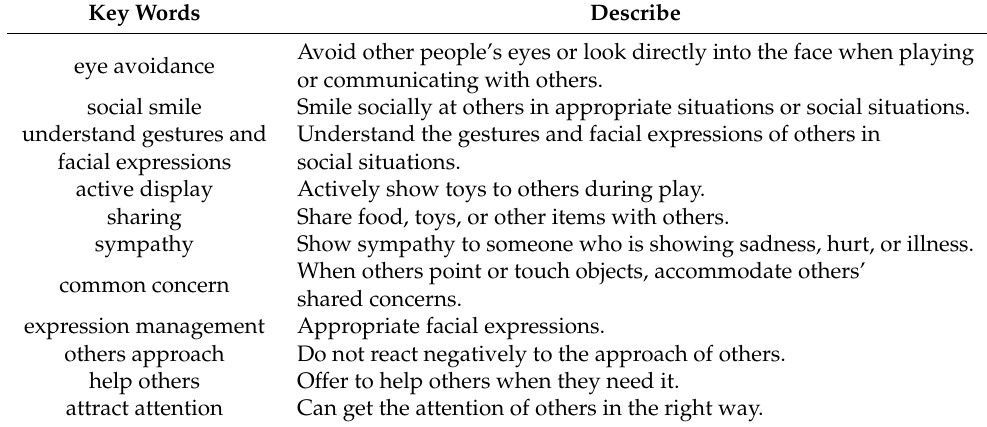
Table 1. Autism Diagnostic Scale.